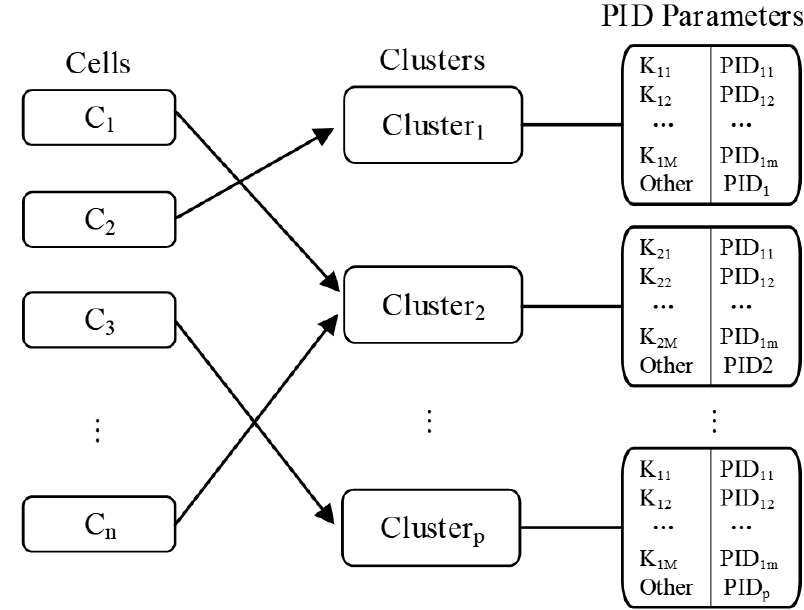
Figure 3. Mapping of grid cells, clusters, and PID parameters.